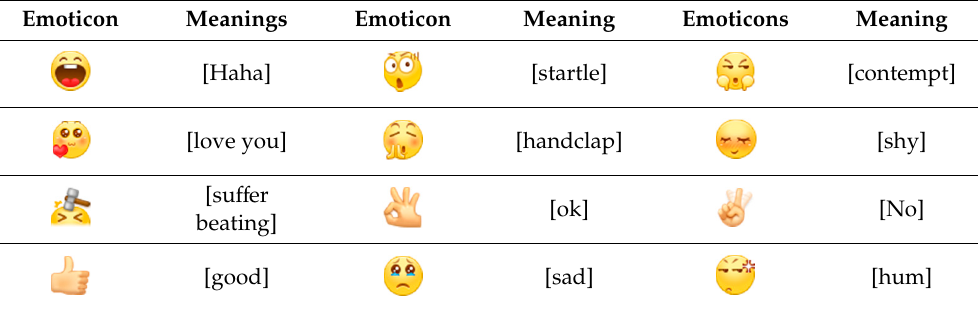
Table 2. Emoticons and corresponding meaning.